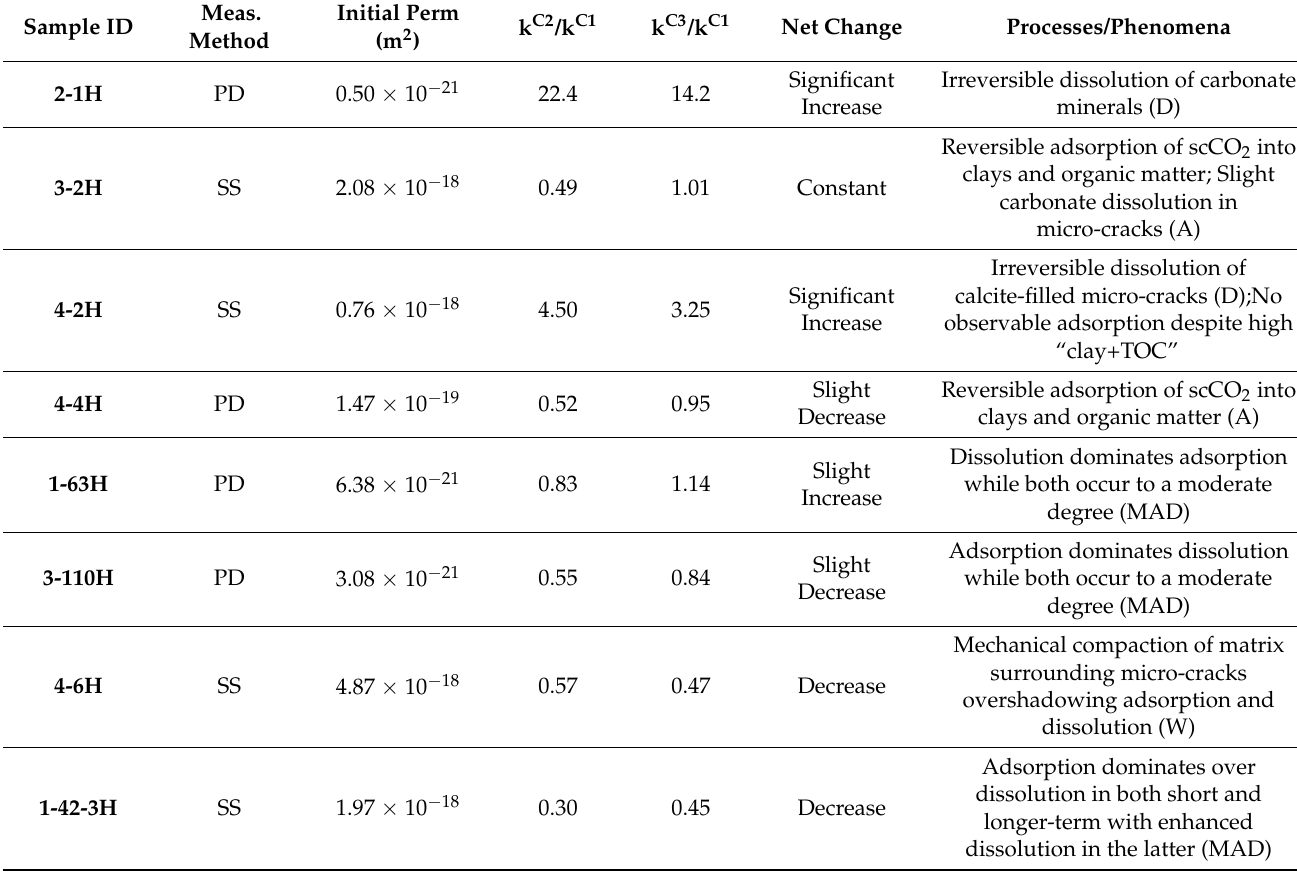
Table 2. Summary of the results of 8 samples tested in this study, at an effective stress of 30 MPa, including initial permeability values and their changes by scCO 2 along with the contributing processes. Sample